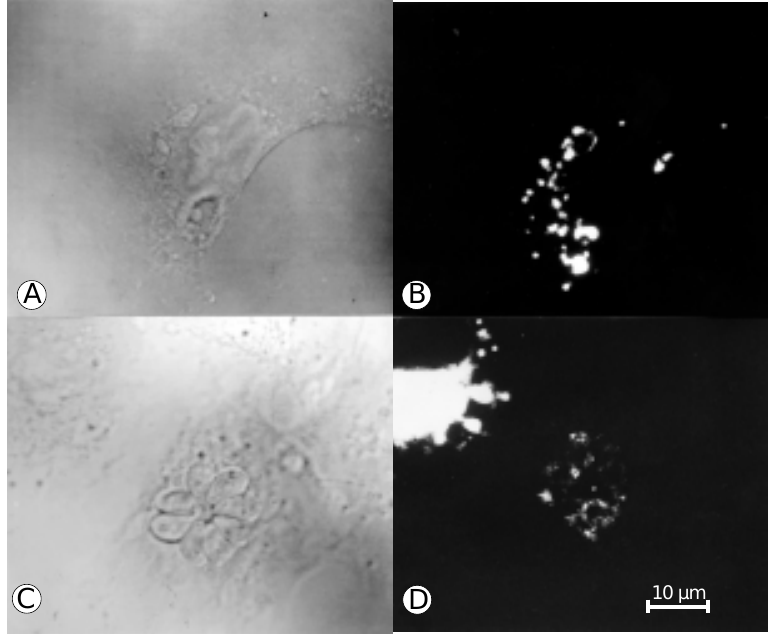
Figure 3 - Labeling of Vero cells with PKH26 and observation by differential interference microscopy (A,C) and CLSM (B,D). At early infection times (1 h) labeling of tachyzoites of Toxoplasma gondii attached to the host cell surface or recently internalized is evident (B). After prolonged incubation times (24 h) the parasites are still labeled (D). Bar = 10